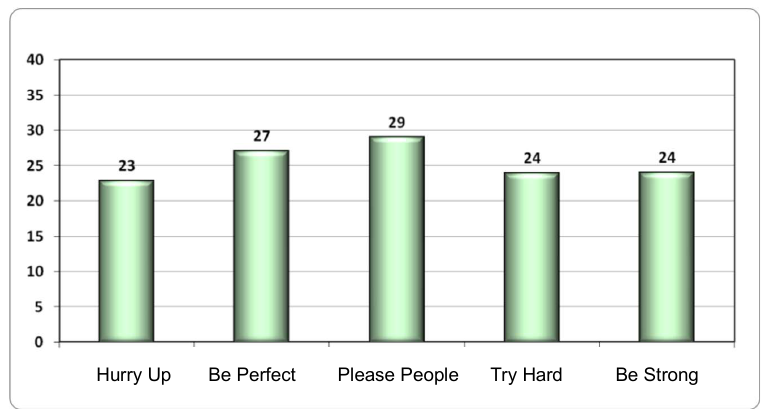
Figure 3. Presence of the five working styles in the profession IT